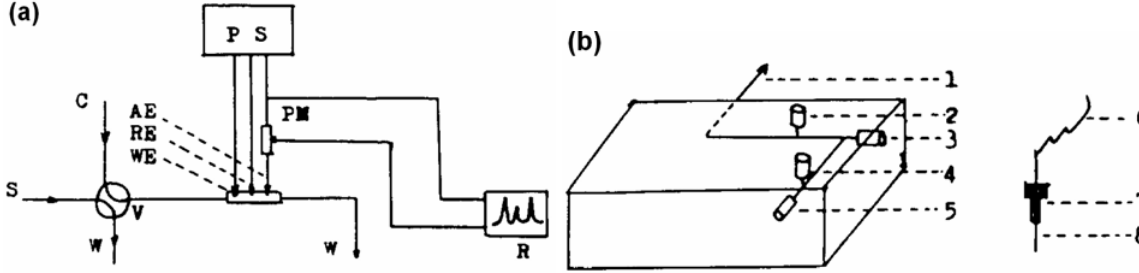
Figure 6. The Schematic diagram of ( a ) the FIA apparatus and ( b ) the flow through cell. PS: potentiostat; C: carrier; PM: potentiometer; AE: auxiliary electrode; RE: reference electrode; WE: working electrode; S: sample; V: valve; W: waste; R: recorder. 1: outlet; 2: reference electrode chamber; 3: auxiliary electrode chamber; 4: inlet; 5: enzyme electrode chamber; 6: cable; 7: Teflon; 8: platinum wire enzyme electrode [64].